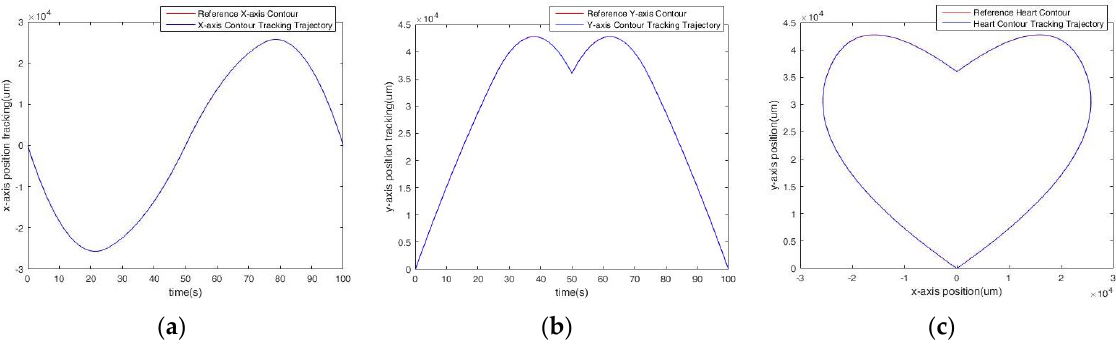
Figure 13. The path trajectory of the experiments. ( a ) The X − axis tracking response, ( b ) the Y − axis tracking response, ( c ) the heart path response.